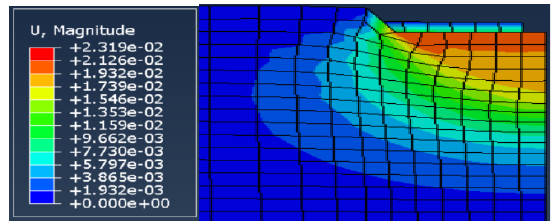
Figure 22 : Displacement contours of case 1 at h/B = 1.75 for L/B=1. Figure 23 : Displacement contours of case 8 at h/B = 1.75 for L/B=1